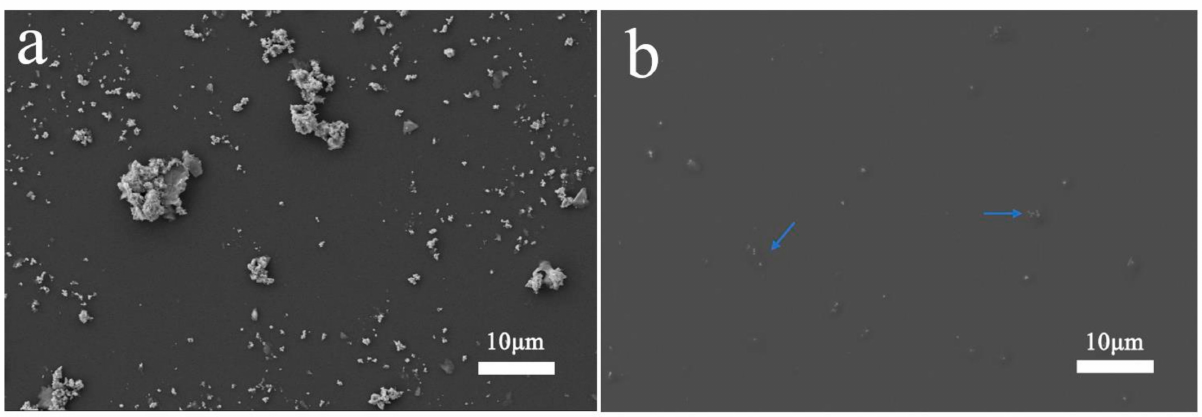
Figure 12. SEM of dispersion of ( a ) IF–WS 2 /PAO6 without span 80 and ( b ) IF–WS 2 /PAO6 with span 80 with the content of 0.25%.